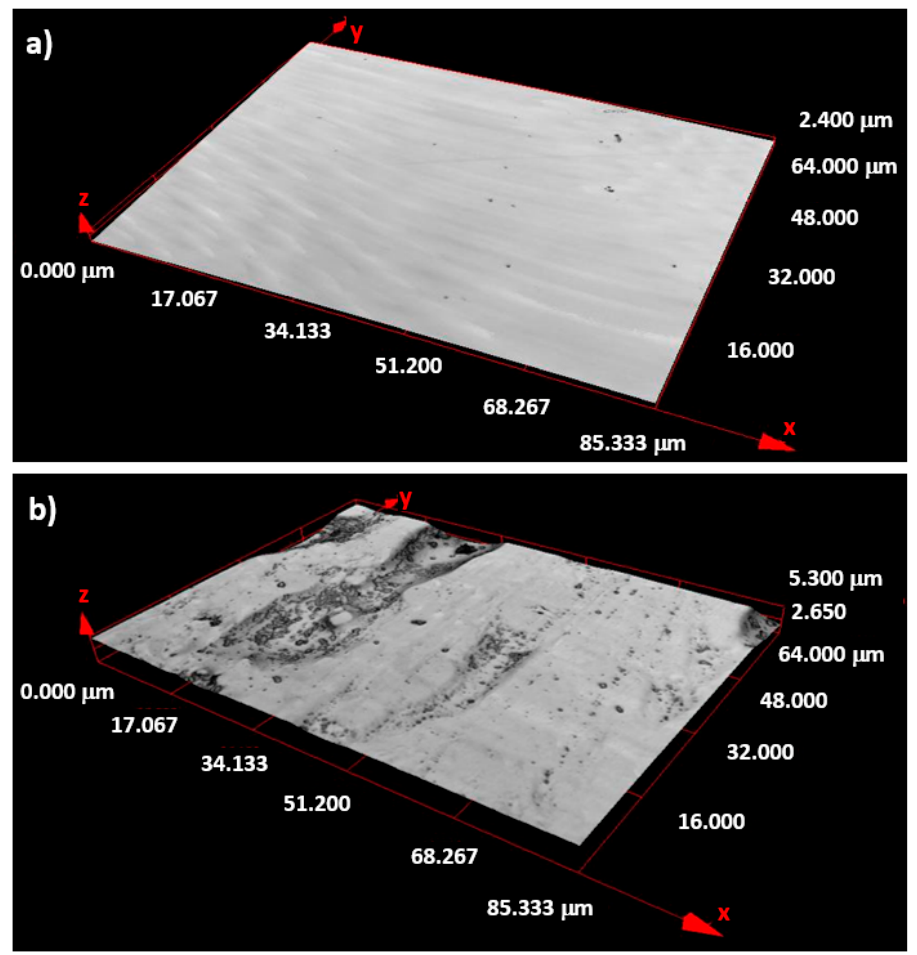
Figure 1. Morphology of the as-prepared FeCoB amorphous ribbon obtained from the ( a ) air and ( b ) wheel surface using the confocal microscope Olympus LEXT 3100.